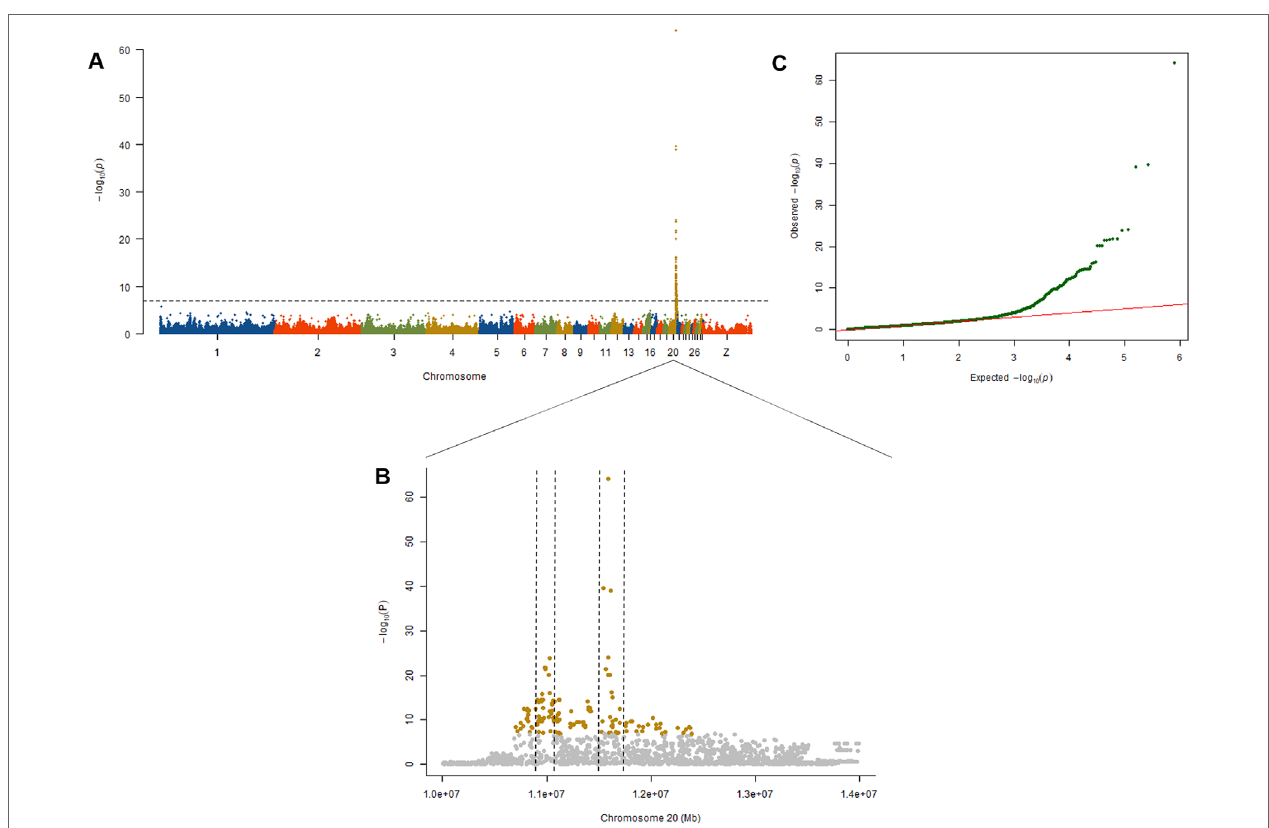
FIGURE 4 | Results from the genome-wide association study (GWAS) of comb color phenotype. (A) Manhattan plot of the GWAS for the comb color phenotype; the y axis shows −log10 P values adjusted by Bonferroni approach for the association tests, and the dashed horizontal line indicates the genome-wide significant threshold value (1.23E-7). (B) A scatter plot presenting all the single-nucleotide polymorphisms (SNPs) tested on chromosome 20 for the comb color phenotype. The extremely significant SNPs in the two peaks are in the two duplications related to fibromelanosis (FM). Among these SNPs, 25 are located in duplication 1, and 23 are located in duplication 2. (C) The quantile–quantile plot of the P values, the x -axis shows the expected −log10-transformed P values, and the y -axis shows the observed −log10-transformed P